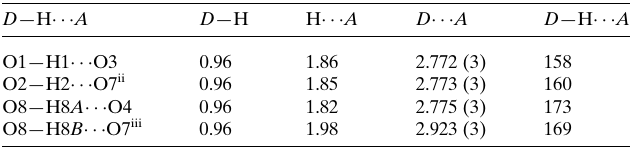
Table 2 Hydrogen-bond geometry (A˚ , (cid:4) ).